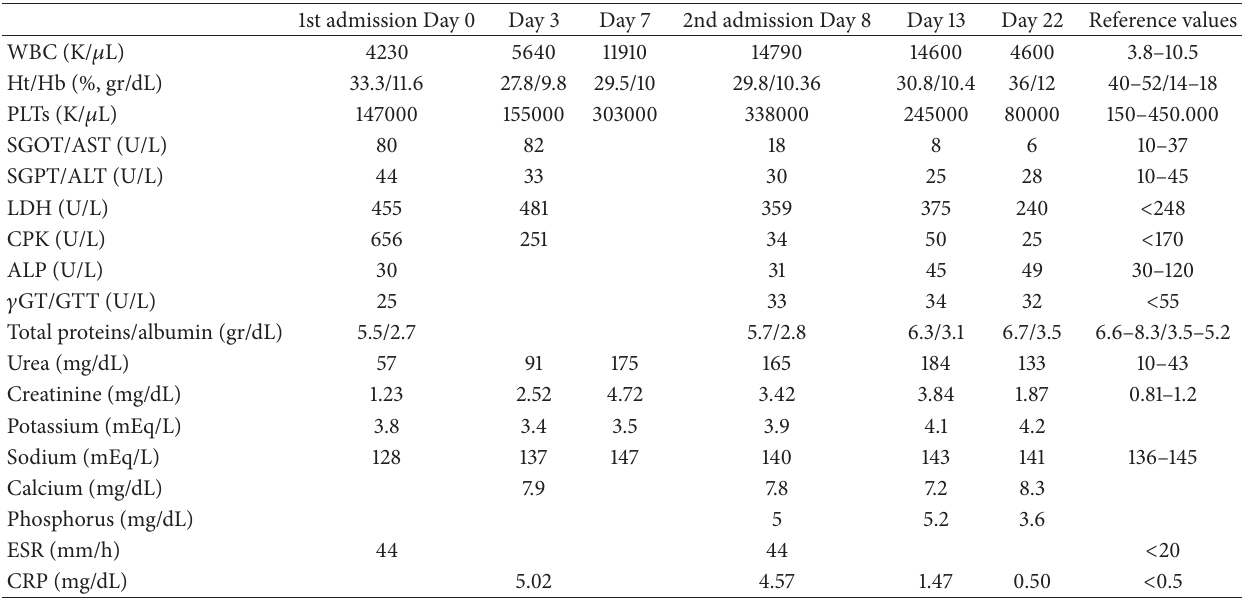
Table 1: Changes in laboratory values during the clinical course of two hospitalizations.